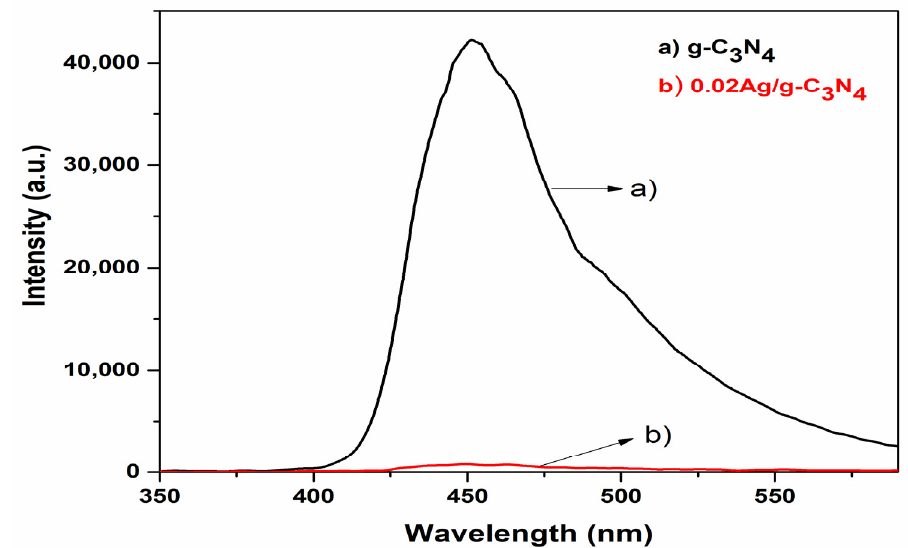
Figure 8. Typical emission spectrum of pure g-C 3 N 4 and 0.02Ag/g-C 3 N 4. The rate of H 2 production in an aqueous solution for g-C 3 N 4 , 0.005 Ag-g-C 3 N 4 , 0.01 Ag-g-C 3 N 4 , 0.015 Ag-g-C 3 N 4 , 0.02 Ag-g-C 3 N 4, and 0.025 Ag-g-C 3 N 4 was examined; the re-